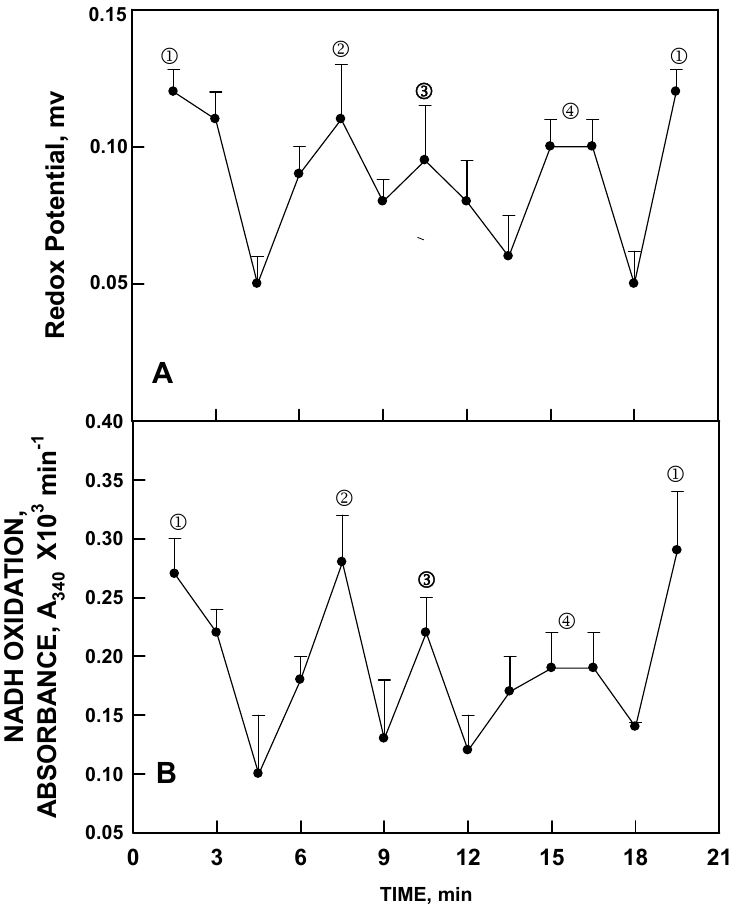
Figure 4. Decomposition fits ( n = 3) as in Figure 3 except for pure water. The oscillatory pattern is similar except that in the absence of Cu II , the period length is reduced from 24 min to about 18 min and maxima ④ and ⑤ are incompletely resolved to yield a 4 maxima pattern with ( A ) maxima ① and ② separated by 6 min and ( B ) maxima ③ and ④ separated from each other and from maxima ① and ② by 4